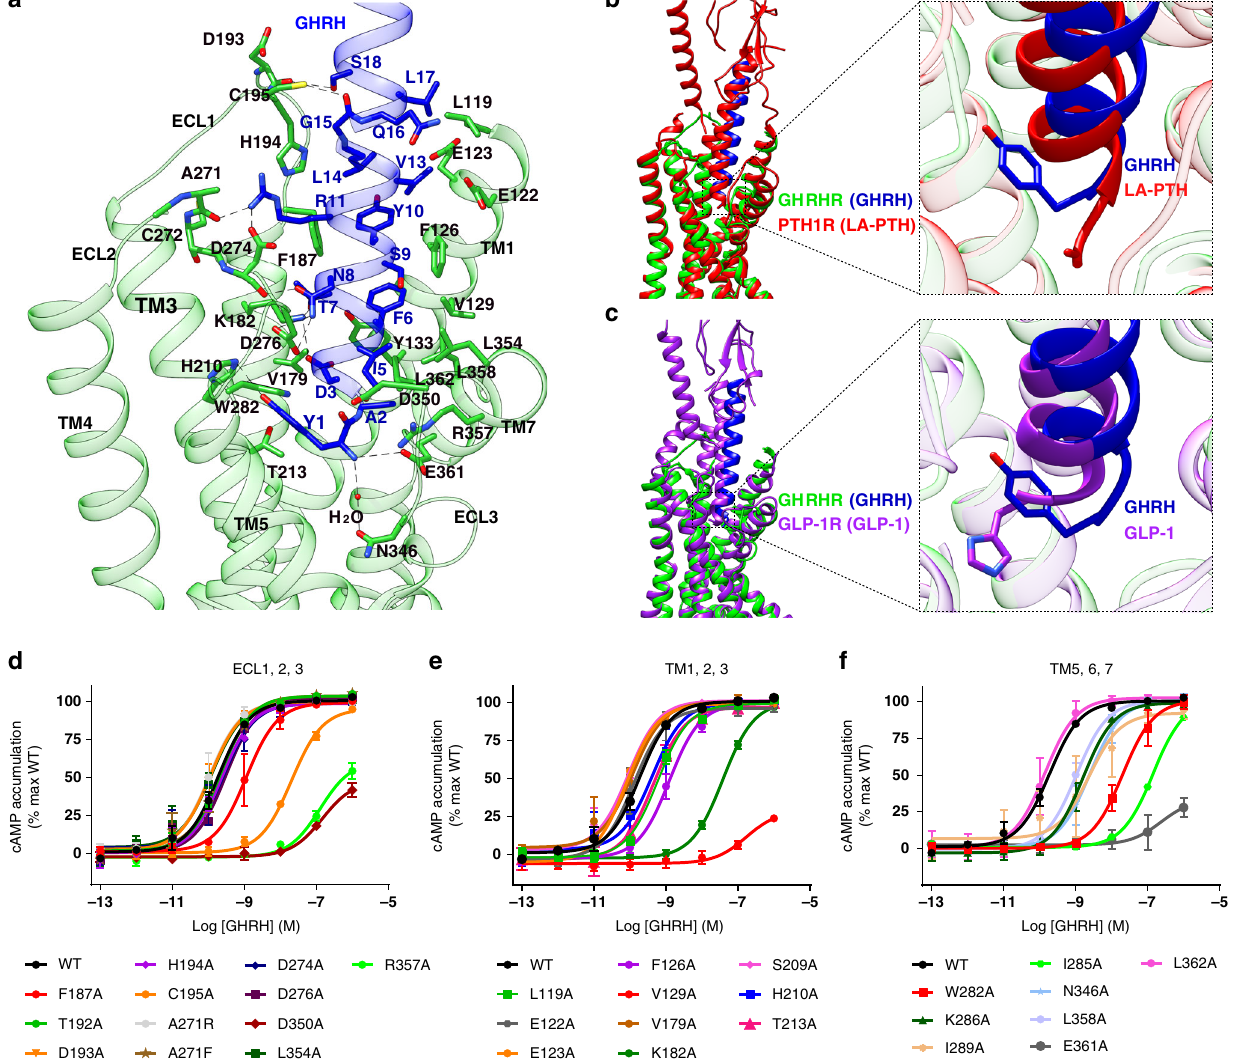
Fig. 2 Molecular recognition of GHRH by GHRHR and comparison of that with LA-PTH – PTH1R and GLP-1 – GLP-1R. a Detailed interaction between GHRH and the TMD pocket of GHRHR with hydrogen bonds shown as dotted lines. b , c Pairwise comparison of GHRH bound to GHRHR with GLP-1 and LA-PTH in complex with their corresponding receptors, showing the relative positions of peptide ligands. Lime green, GHRHR; blue, GHRH; red, PTH1R and LA-PTH; purple, GLP-1R and GLP-1. d – f The effects of mutation in the ligand-binding pocket on cAMP accumulation. cAMP levels were measured in wild-type (WT) receptor and alanine mutants in ECL1, 2, and 3 ( d ), TM1, 2, and 3 ( e ), and TM5, 6, and 7 ( f ). cAMP signals were normalized to the maximum response of WT and concentration – response curves were analyzed using a three-parameter logistic equation. Data shown are means ± S.E.M. of at least three independent experiments ( n = 3 – 5), conducted in triplicate. Source data are provided as a Source data fi their fi rst residues of the side chain have different orientations (Fig. 2b). The hydroxyl group of Tyr 1P forms hydrogen bonds with